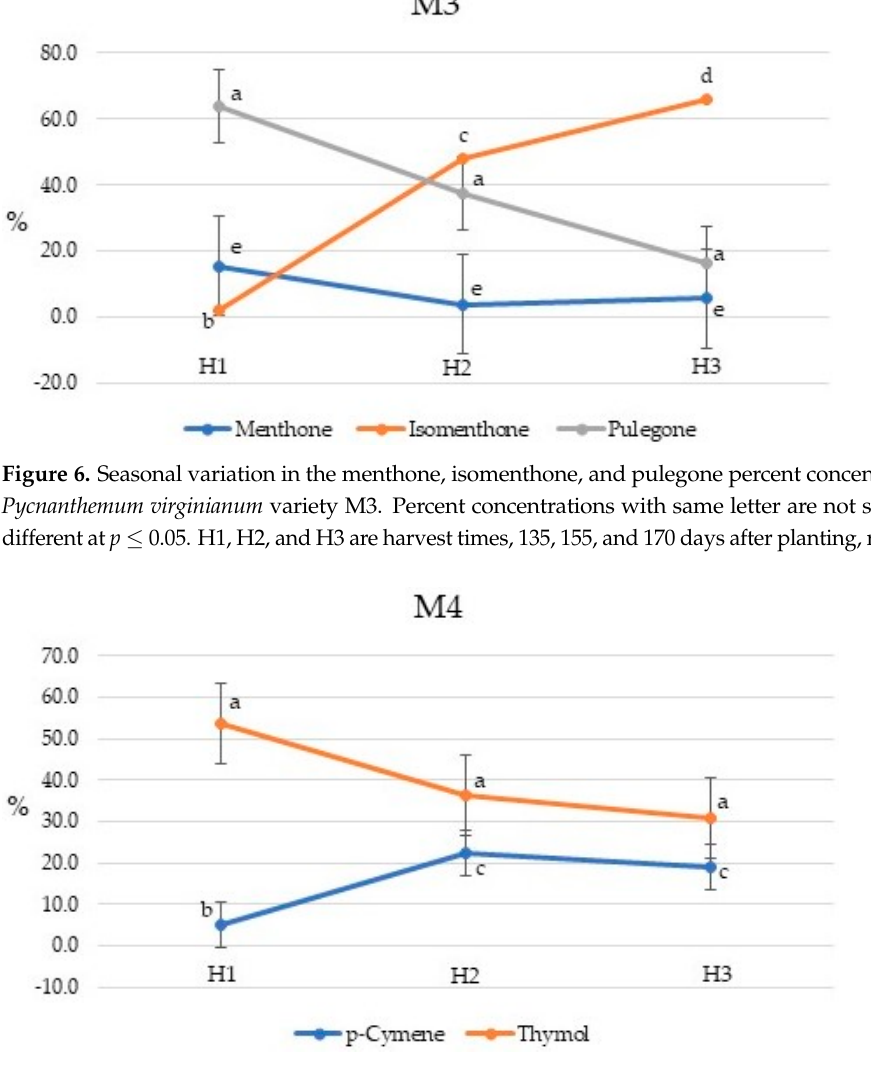
Figure 7. Seasonal variation in the p -cymene and thymol percent concentrations for Pycnanthemum virginianum variety M4. Percent concentrations with same letter are not significantly different at p ≤ 0.05. H1, H2, and H3 are harvest times, 135, 155, and 170 days after planting, respectively.